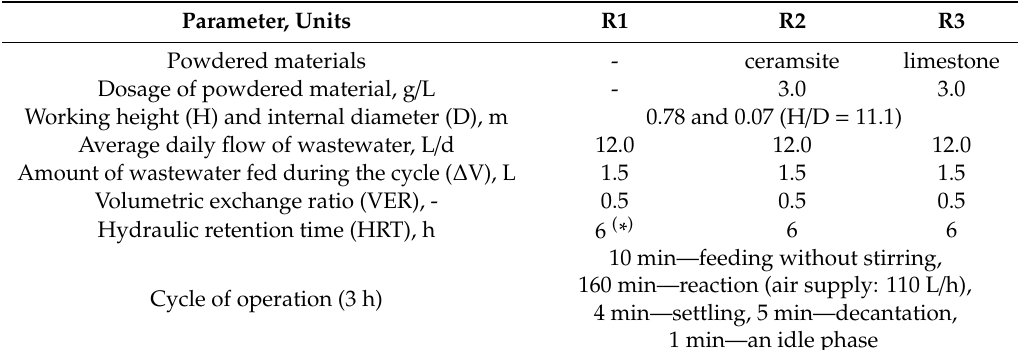
Table 3. Technical parameters of the reactors used in this study (adopted according to